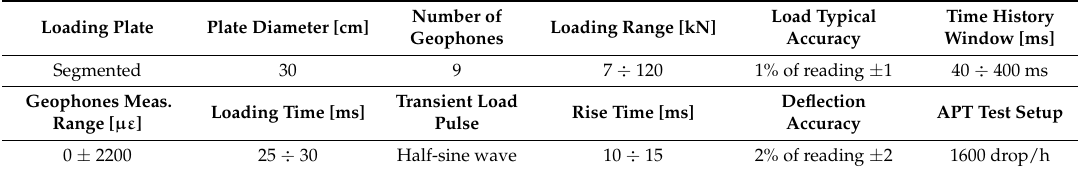
Table 3. Main characteristics of the FFWD and APT test setup